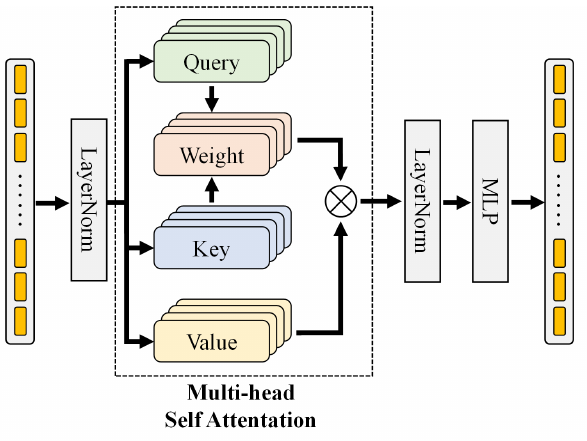
Figure 3. The structure of the transformer